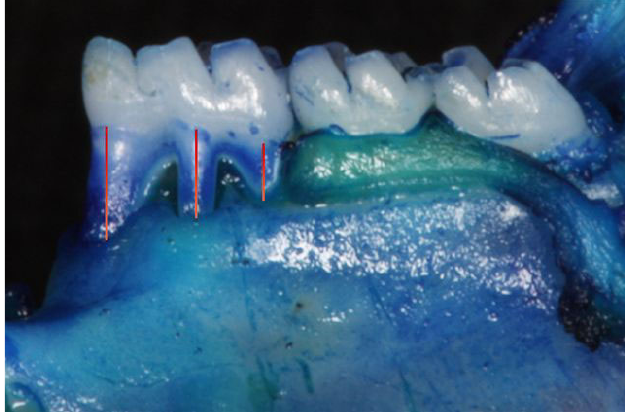
Fig. 1 - Morphometric parameter evaluated: red lines represent the distance to the cementoenamel junction from the alveolar bone crest